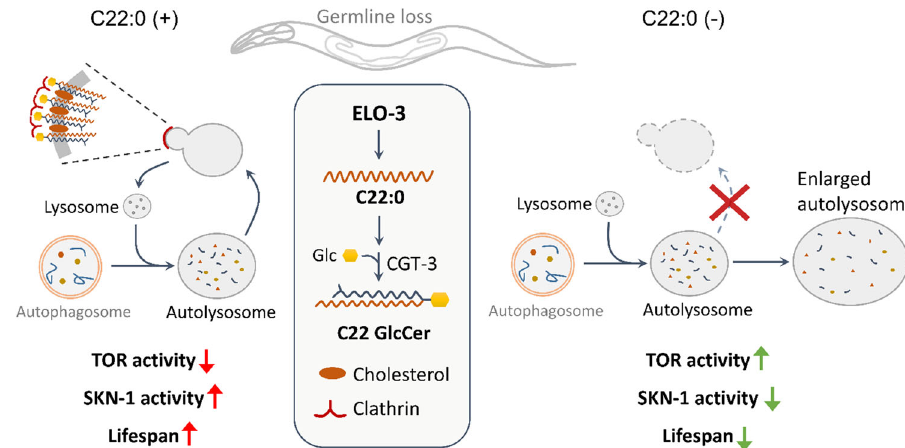
Fig. 8 Model of lifespan regulation by C22:0. ELO-3 regulates the production of BA that is incorporated into C22 GlcCer as the acyl chain (middle). In germline-de fi cient animals, C22 GlcCer regulates clathrin membrane localization and lysosome homeostasis, which is required for TOR inhibition, SKN-1 activation, and lifespan extension (left). In germline-de fi cient animals with reduced C22 GlcCer production, clathrin localization and lysosome regeneration are disrupted, leading to TOR activation and lifespan reduction